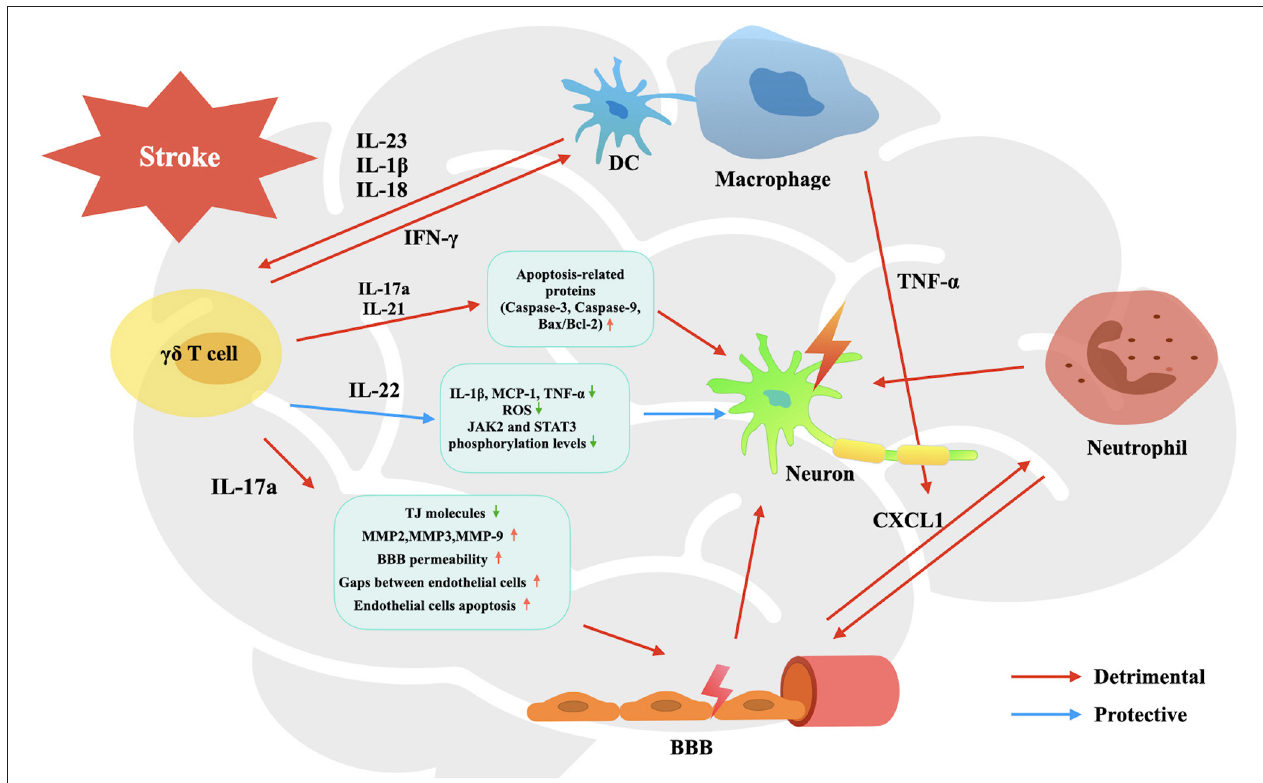
FIGURE 1 | Activation and effects of γδ T cells in the pathophysiology process of CIS. Upon activated by IL-23, IL-1 β and IL-18, infiltrated γδ T cells are stimulated to produce IL-17a, IL-21, IL-22, and IFN- γ . They participate in the pathophysiological process of CIS, involving promoting BBB breakdown, neutrophil infiltration, neuronal cell apoptosis and autophagy, and so on, leading to affected brain tissue damage and neurological